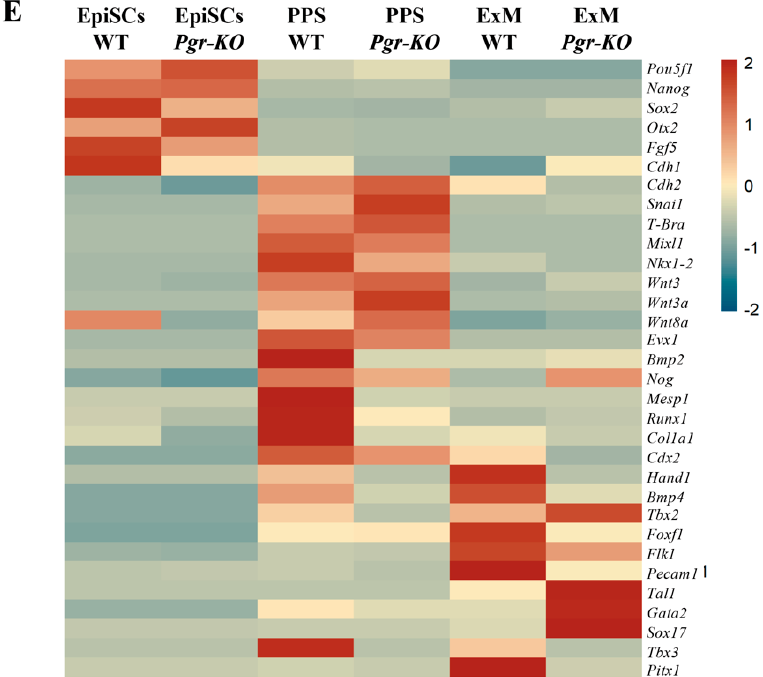
Figure 3. Pgr modulates PPS induction and extraembryonic mesoderm (ExM) formation. ( A ) Schematic illustration of the extraembryonic differentiation protocol. EpiSCs are initially subjected to PPS induction, and thereafter exposed to BMP for additional 24 h to induce ExM differentiation. High levels of BMP restrict PS cells towards extraembryonic mesoderm-like fate. ( B ) Heatmap displaying relative expression of selected differentially regulated genes in EpiSCs, PPS, and ExM (RNA-Seq, p ≤ 0.05, fold-change ≥ 1.5). ( C ) UMAP plots showing gene expression distribution in PPS cells. Individual cells are colored by expression of key posterior primitive streak markers ( T-Bra , Exv1 , and Hand1 ). ( D ) UMAP plots showing gene expression distribution in ExM. Individual cells are colored by the expression of key extraembryonic mesoderm marker genes ( Hand1 , Foxf1 , and Igrf2 ). ( E ) Differential expression analysis of WT and Pgr-KO EpiSCs differentiated towards PPS and ExM revealing downregulation of PPS markers ( Hand1 , Col1a1 , and Bmp2 ) and a stronger effect in ExM ( Hand1 , Foxf1 , Pecam1 , Flk1 , and Bmp4) . Upregulation of Tal1 , Gata2 , and Sox17 in Pgr-KO indicates a shift of ExM towards a hemangioblast fate (RNA-Seq, p ≤ 0.05, fold-change ≥